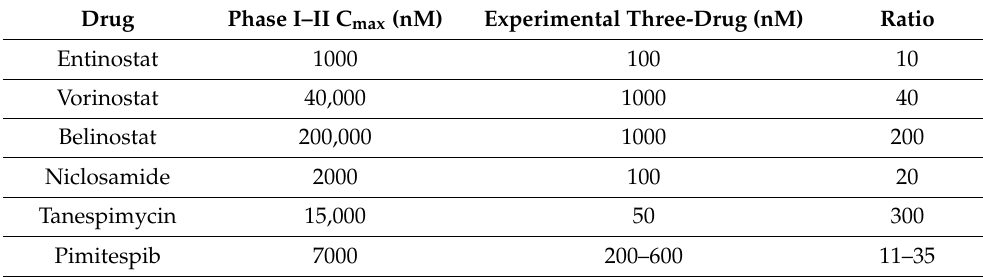
Table 1. The comparison of the peak serum concentrations achieved for HDAC inhibitors, HSP90 inhibitors, Niclosamide, and the drug concentrations used in this study. Drug Phase I–II C max